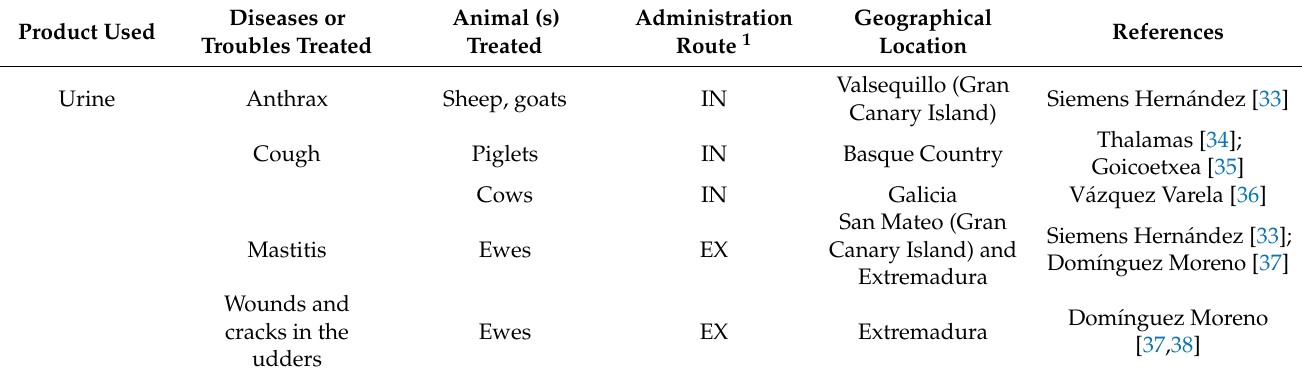
Table 1. Human products used in contemporary Spanish ethnoveterinary